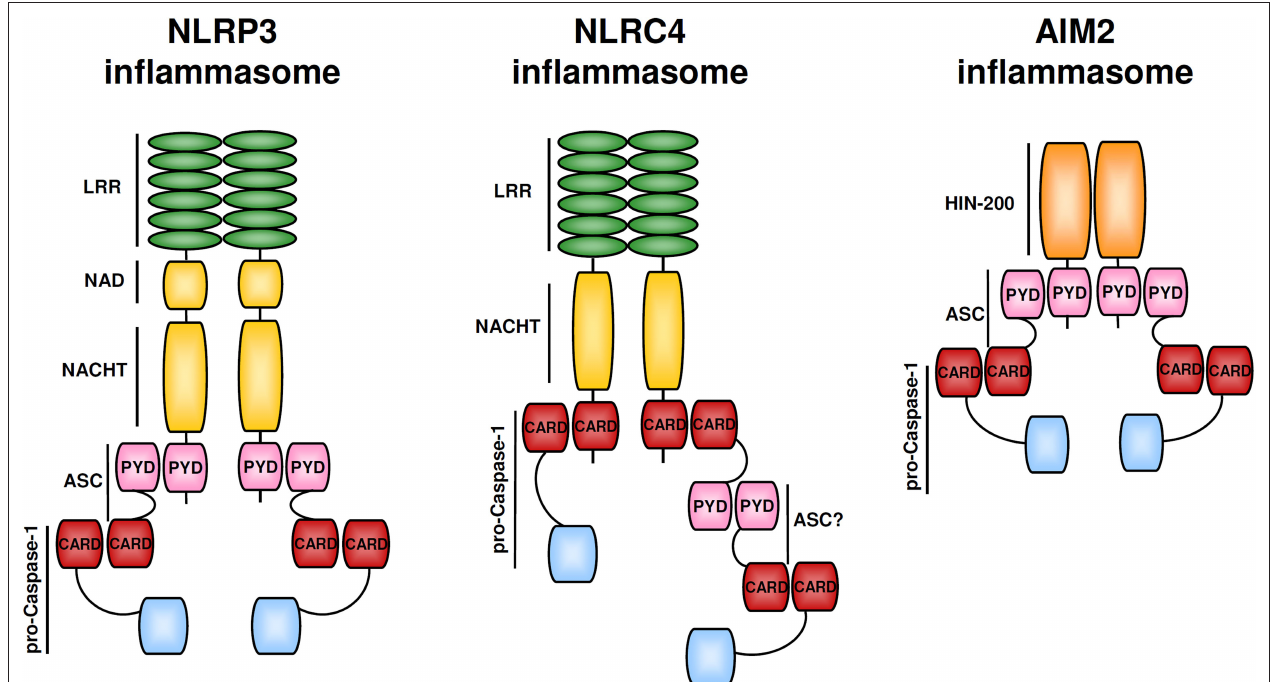
FIgure 1 | NLrP3, NLrC4, and AIM2 inflammasomes. Inflammasomes are assembled by self-oligomerizing proteins. The NLRP3 inflammasome consists of NLRP3, ASC, and caspase-1. NLRC4 can directly interact with procaspase-1 but maximal NLRC4 inflammasome activation might require ASC. The AIM2 inflammasome is composed of AIM2, ASC, and caspase-1. The PYD domain